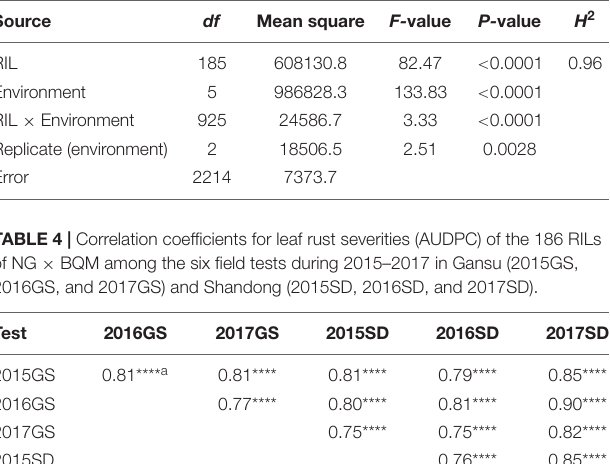
TABLE 3 | Analysis of variance (ANOVA) of leaf rust severities (AUDPC) for the 186 recombinant inbred lines (RILs) of NG × BQM in different field environments.